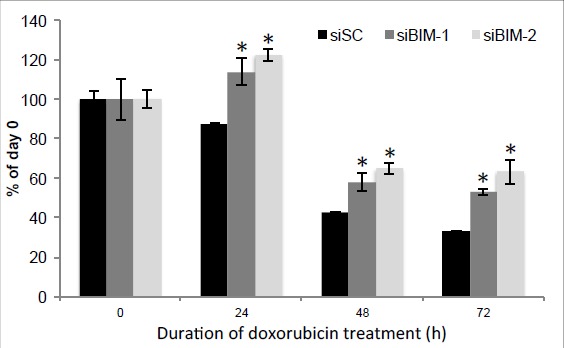
Knockdown of BIM rescue doxorubicin suppression of H460 cell proliferation.H460 cells were transfected with two siRNAs against BIM, and 48 hr after transfection, cells were treated with 0.5 μM Dox for indicated duration and cell proliferation was determined by using the sulforhodamine B (SRB) assay. * p<0.05. Error bars, SD.